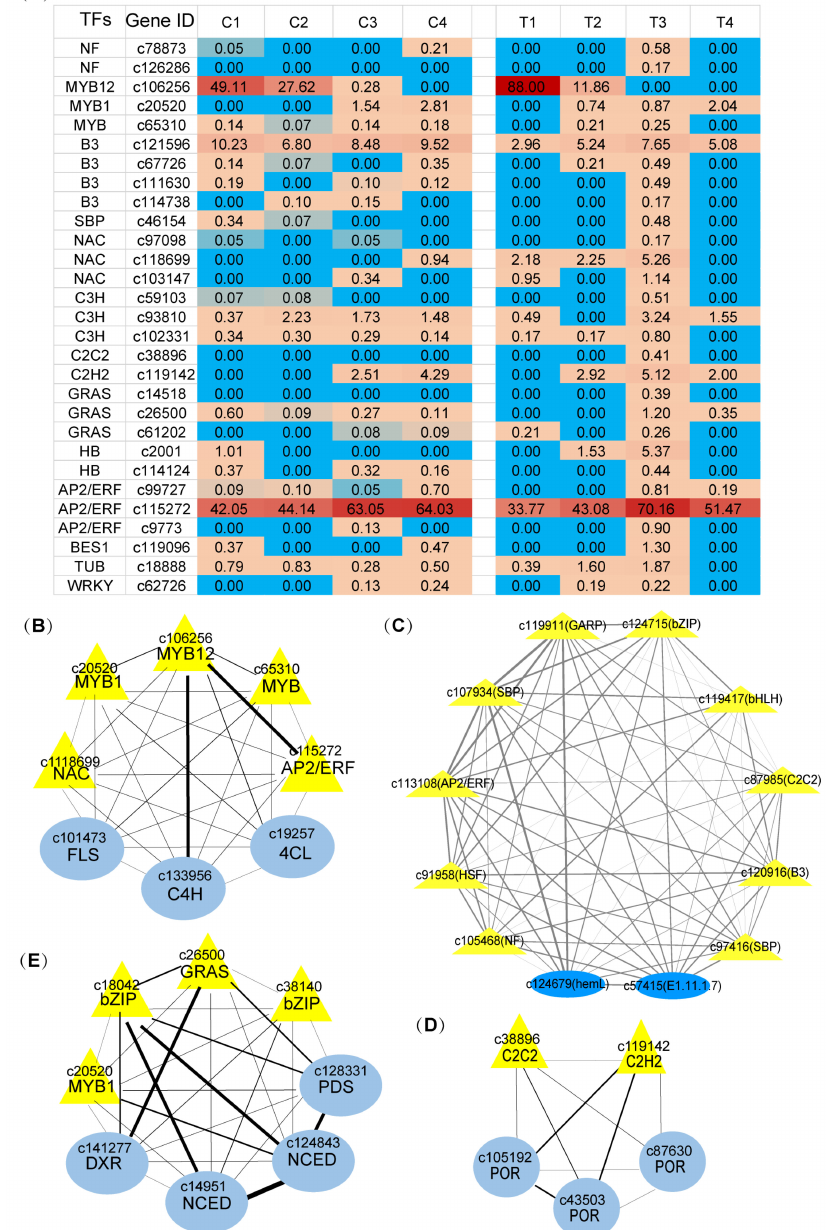
Figure 7. Coexpression network of transcription factor and structure genes related to floral pig- ment biosynthesis and the floral fragrance biosynthesis pathway during flower development. ( A ). 28 transcription factors related to pigment biosynthesis and the floral fragrance biosynthesis pathway during flower development; from blue to red indicated the FPKM values of genes from low to high, and the value is indicated in the box. ( B – E ). Coexpression network of transcription factors (yellow triple angle) and structure genes (blue circle) related to floral pigment. ( B ), flavonoids biosynthesis pathway; ( C ), chlorophyll biosynthesis pathway; ( D ), chlorophyll biosynthesis pathway; ( E ), carotenoid metabolism pathway and floral fragrance ( B ), benzenoid/phenylpropanoid biosyn- thesis pathway; ( D ), chlorogenic acid biosynthesis pathway) biosynthesis pathway. Edge width indicates the strength of the relation between two